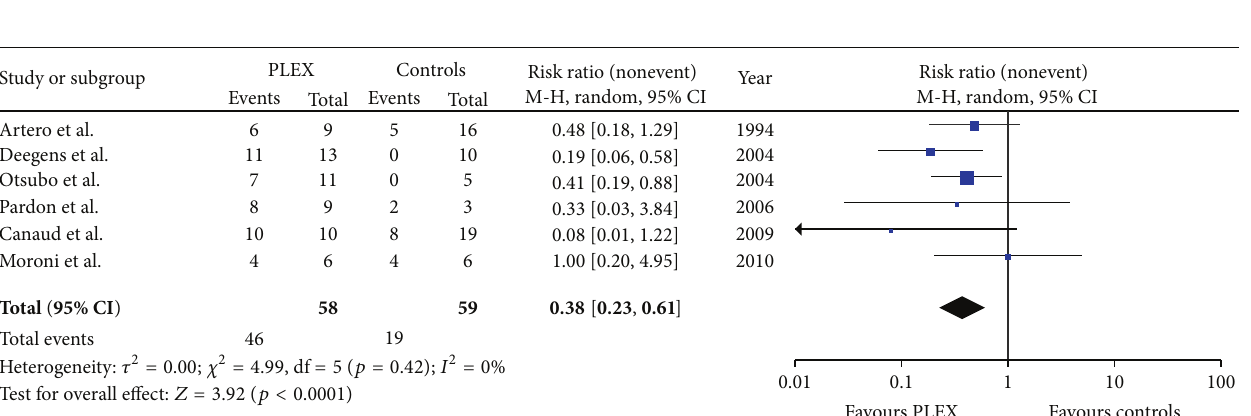
Figure 2: Forest plot of the effect of plasma exchange on the composite endpoint of partial or complete proteinuria remission. CI: confidence intervals; M-H: Mantel-Haenszel method; PLEX: plasma